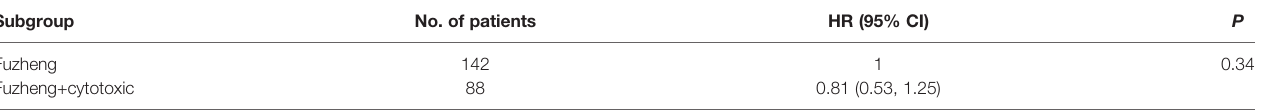
TABLE 4 | Subgroup Analysis of Disease-free Survival in TCM Group.